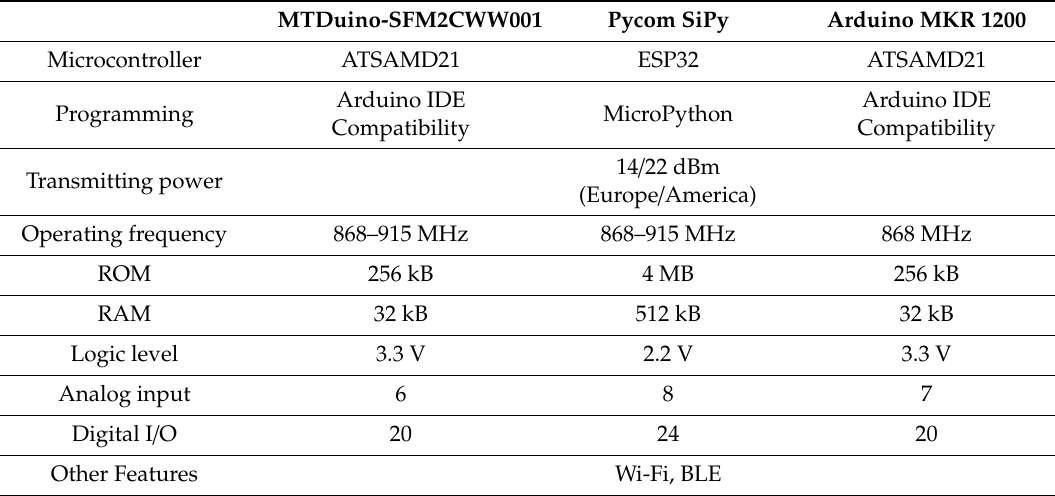
Table 7. Technical characteristics for SIGFOX integrated boards.